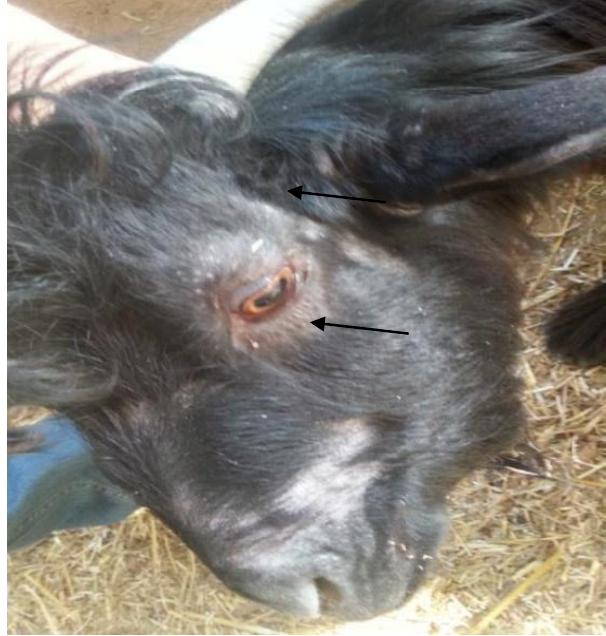
Figure 1. Goat on the 10 th week (end of the study) with rough and hair loss in head